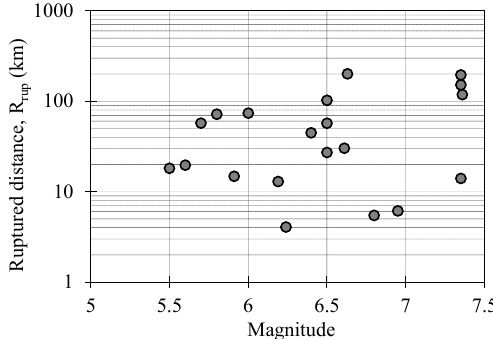
Figure 13. Magnitude versus closet ruptured distance of selected ground motions.